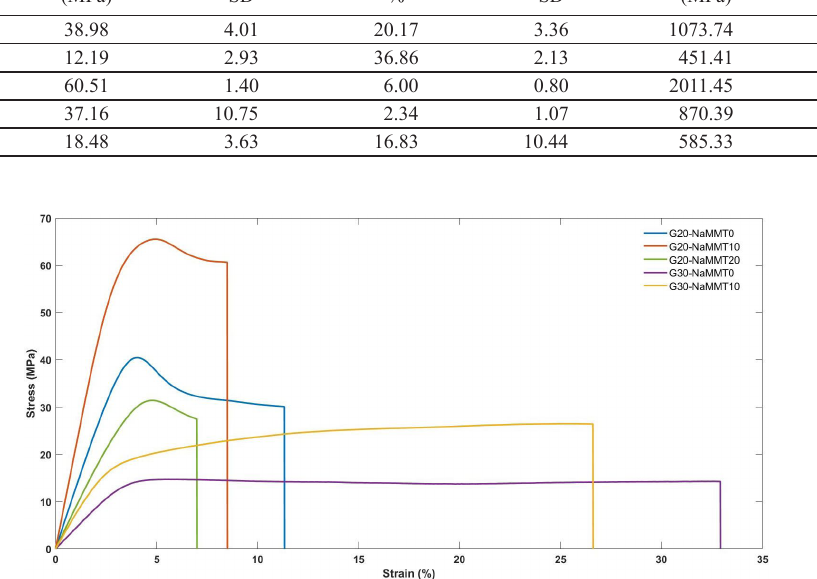
Table 1. Mechanical properties (tensile strength, elongation at break and elasticity modulus) of the tested films. Specimen